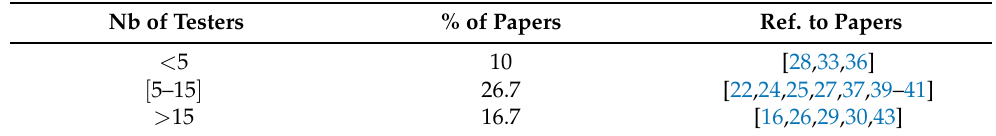
Table 14. Number of VIP